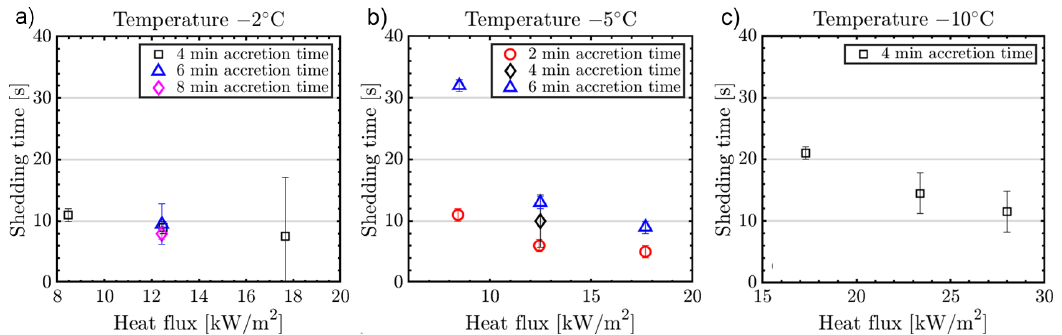
Figure 12. Shedding times of the parting strip de-icing ice protection system for three different temperatures: T = − 2° ( a ), T = − 5° ( b ), and T = − 10° ( c ).